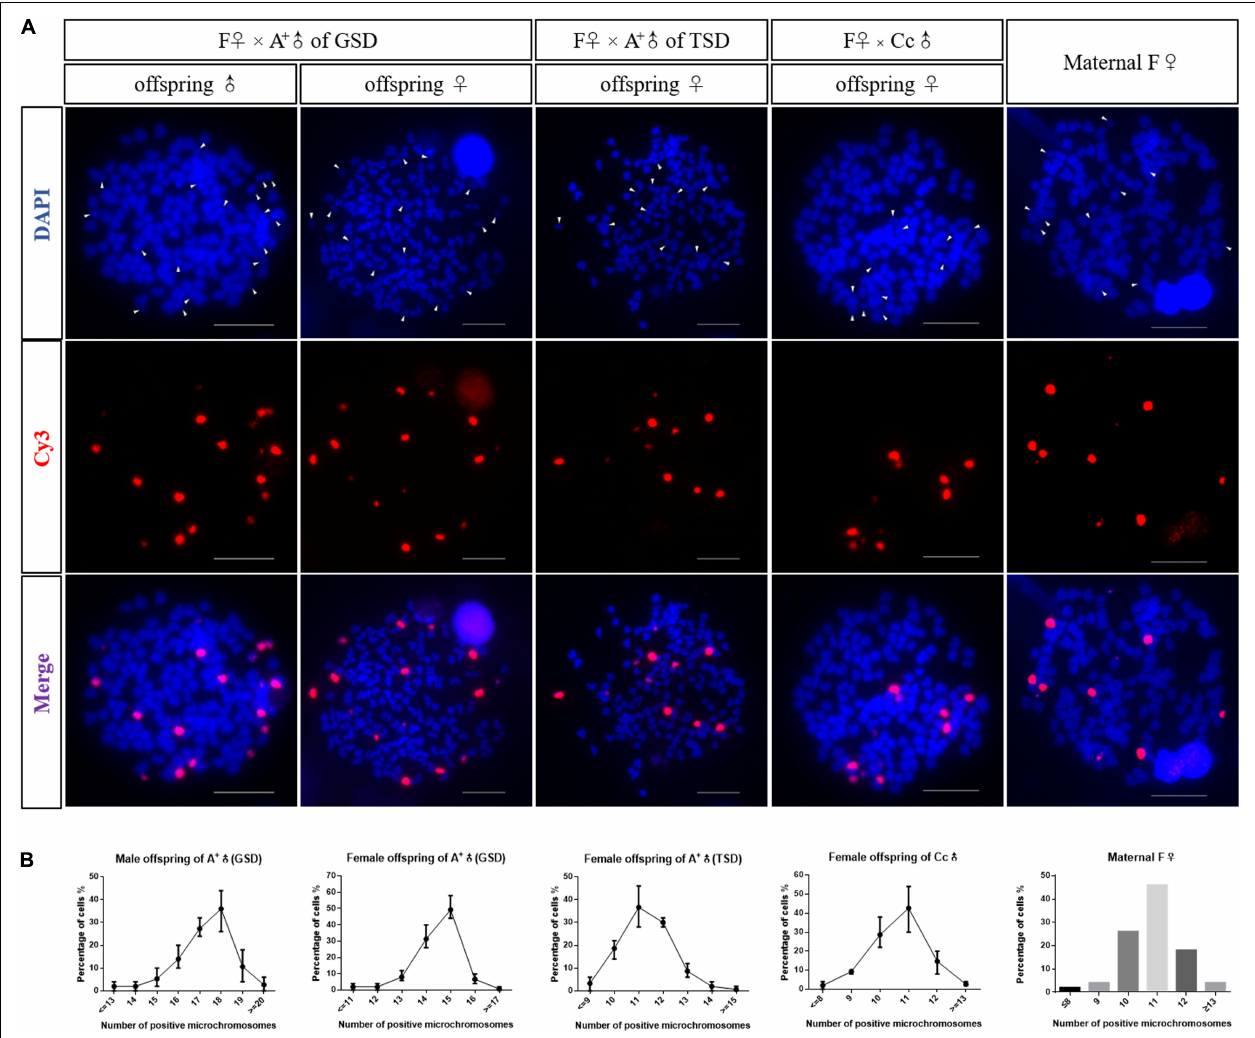
of GSD, a female offspring of A + of GSD, a FIGURE 2 | Microchromosome number in the offspring. (A) FISH analysis in metaphases of a male offspring of A + female offspring of A + of TSD, a female offspring of Cc , and the maternal F , respectively. Microchromosome probes were labeled with Cy3 and red ♂ ♂ fluorescence was produced. All metaphase chromosomes were stained with DAPI and appeared as blue. Arrowheads indicate microchromosomes. Scale bars ♂ ♂ ♀ represent 10 µ m. (B) Statistical data of microchromosome number in male offspring of A + of GSD, female offspring of A + of GSD, female offspring of A + of TSD, female offspring of Cc , and the maternal F . Three individuals were examined for each kind of offspring, and 50 metaphases were counted for each tested ♂ ♂ ♂ individual. Number of microchromosomes is exhibited on the X -axis, and the percentage of total cells is shown on the Y -axis. The data of microchromosome ♂ ♀ number in the maternal F was represented in histogram. Detail statistical data of microchromosome number are given in Supplementary Figure 1 ♀